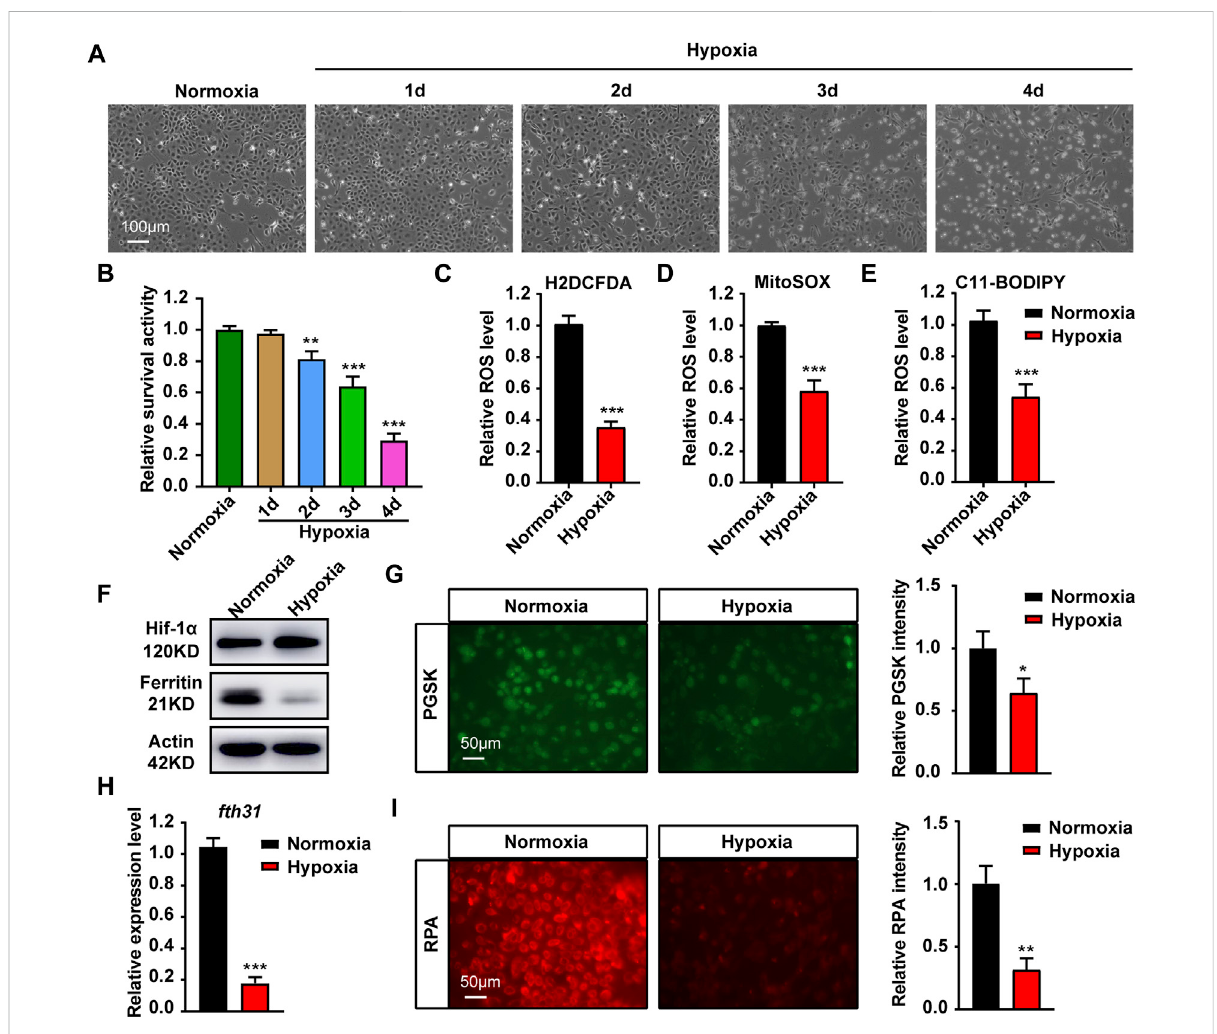
FIGURE 1 Hypoxia stress affects cell growth, ROS production and iron metabolism in cytoplasma and mitochondria. (A) Microscopic analysis of morphologicalchangesofZFLcellsundernormoxiaorhypoxiafor1,2,3and4 d. (B) CellViabilityanalyzedwithPrestoBlue ™ HSCellViabilityRegent under normoxia or hypoxia for 1, 2, 3 and 4 d. (C – E) Analysis of changes in total ROS (C) , mitochondrial-derived ROS (D) and lipid peroxidation (E) levels in cells with CM-H2DCFDA, MitoSOX and C11-BODIPY probe under normoxia and hypoxia for 3 days. (F) Western blot analysis of Ferritin expressioninZFLcellsculturedundernormoxiaandhypoxiafor3 days. (G) PhenGreen ™ SK(PGSK)probeanalysisandquanti fi cationofcytoplasmic freeironcontentinZFLcellsaftertreatedundernormoxiaandhypoxiafor3 days. (H) ThemRNAexpressionofmitochondrialironstoragegene fth31 inZFL cellsquanti fi edbyreal-timeRT – PCRundernormoxiaandhypoxiafor3 days. (I) Fluorescence microscope withRPAredindicatoranalysis and quanti fi cation of mitochondrial iron content in ZFL cells treated under normoxia and hypoxia for 3 days. Normoxia was used as a control group